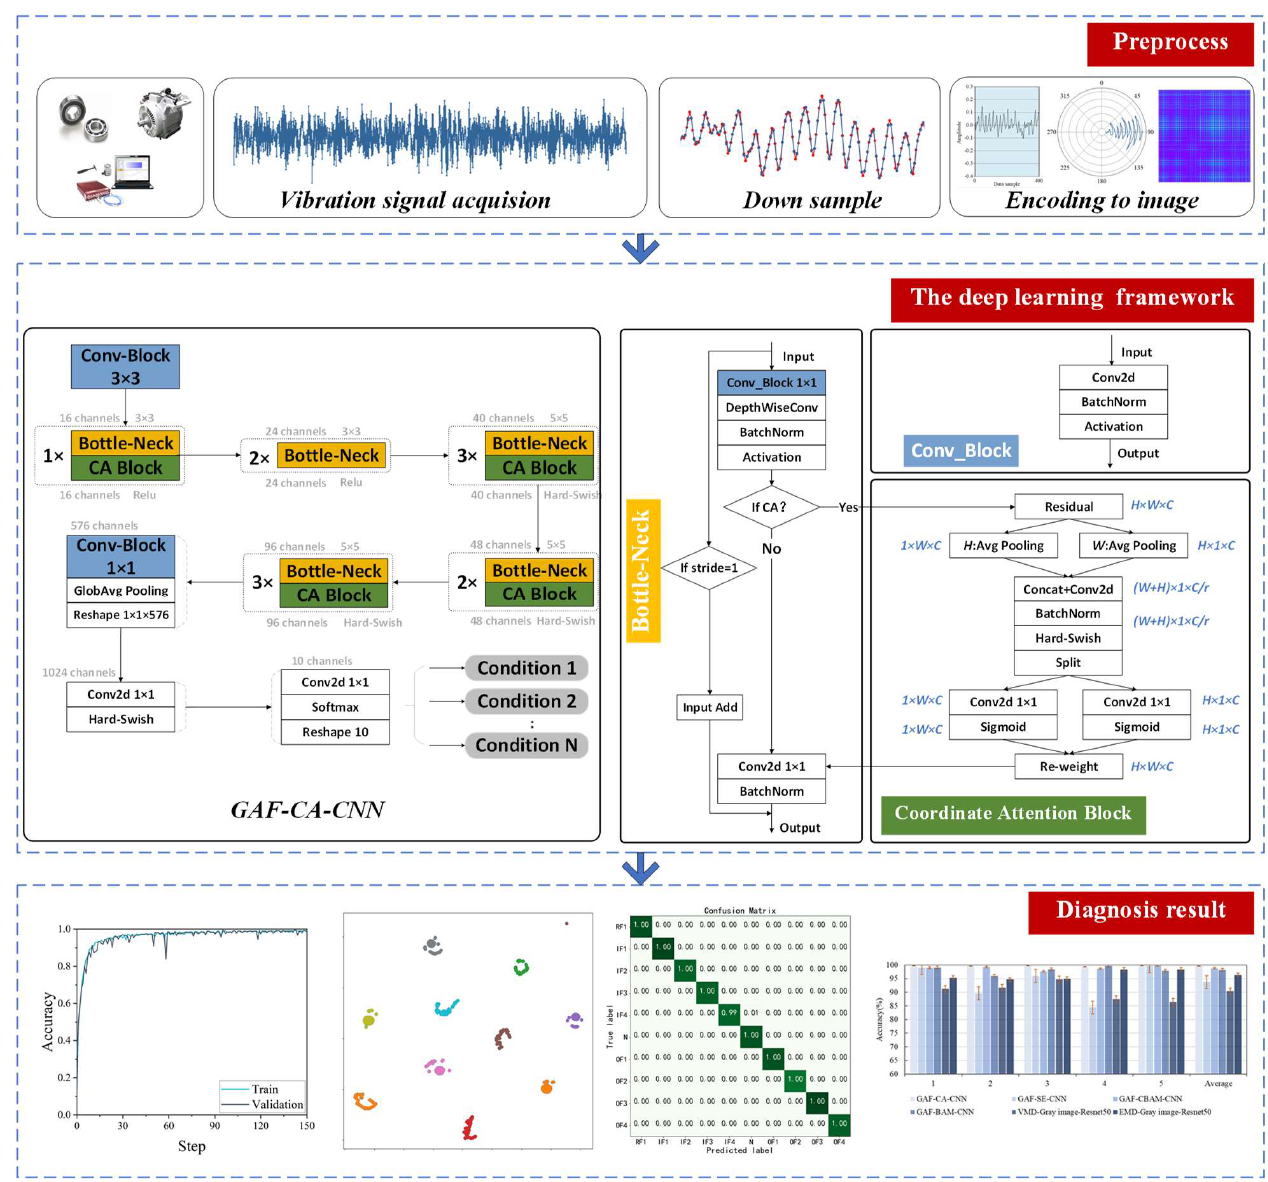
Figure 7. The framework of the proposed method.